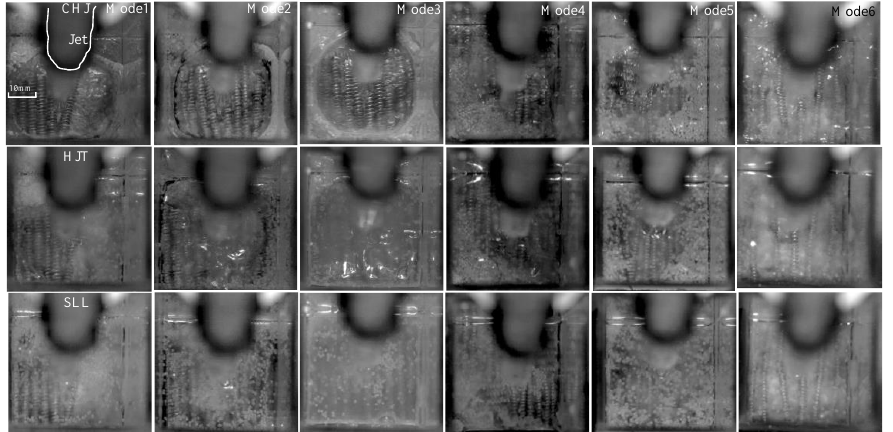
Figure 3. Hydraulic jump form and spring and particle arrangement in three physical forms of hydraulic jump of top view (casting speed of 0.8 m/min, mode 1–6).